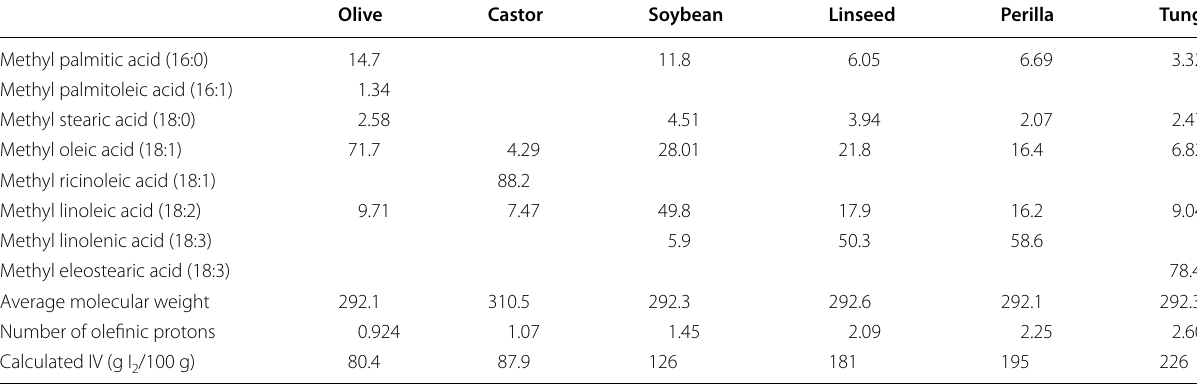
Table 1 The FAME compositions obtained from GC–MS and the calculated IV Olive Castor